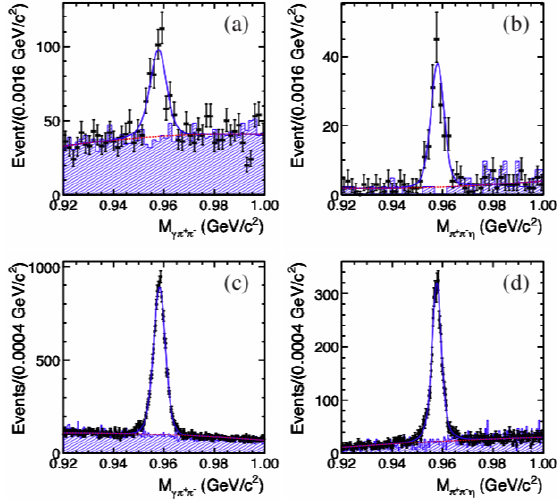
Figure 3. Invariant mass spectra of the η (cid:48) candidates in ψ (2 S ) → p ¯ p η (cid:48) with η (cid:48) → γπ + π − (a), ψ (2 S ) → p ¯ p η (cid:48) with η (cid:48) → ηπ + π − (b), J /ψ → p ¯ p η (cid:48) with η (cid:48) → γπ + π − (c), and J /ψ → p ¯ p η (cid:48) with η (cid:48) → ηπ + π − (d). The dots with error bars are data, the shaded histograms are the backgrounds from inclusive MC samples, the blue solid curves are the fit results, and the red dashed curves are the backgrounds from fit.